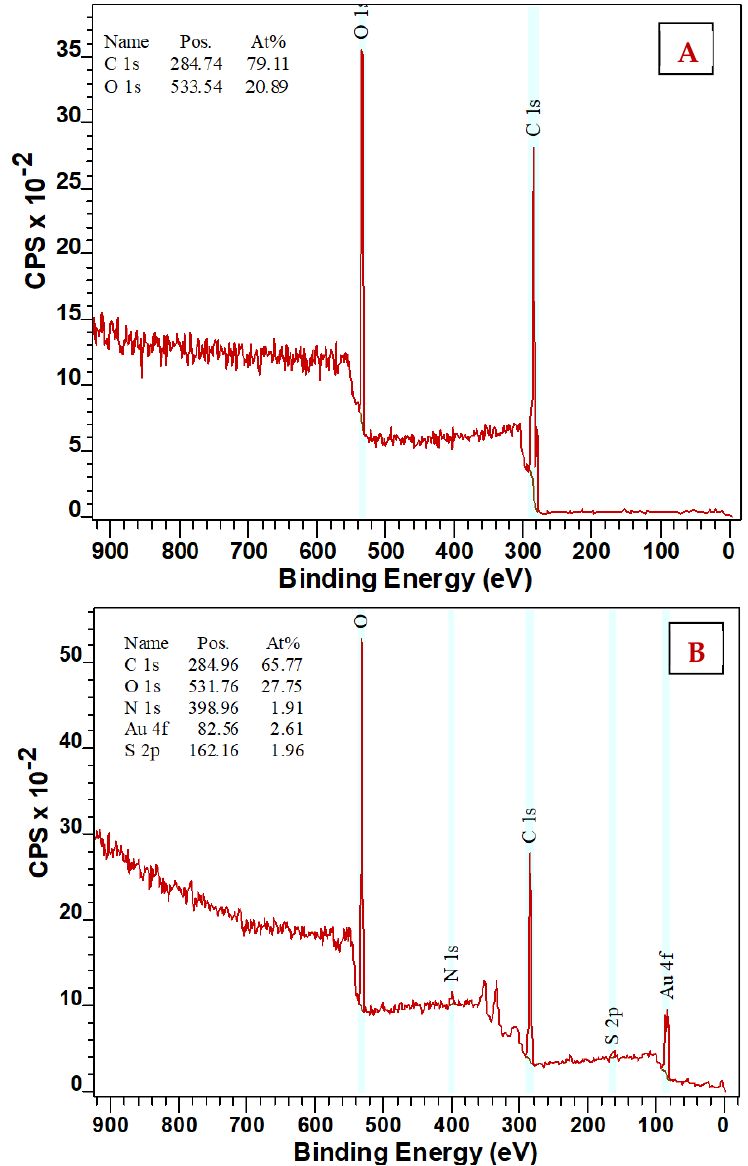
Figure 10. XPS analysis: ( A ) non-modified PEN and ( B ) PEN plasma modified for 400 s after 24 h immersion in AuNP/PEG/NALC/H 2 O solution (NALC/H 2 O ratio-1.5 g/100 mL, AuNP deposition time-600 s).